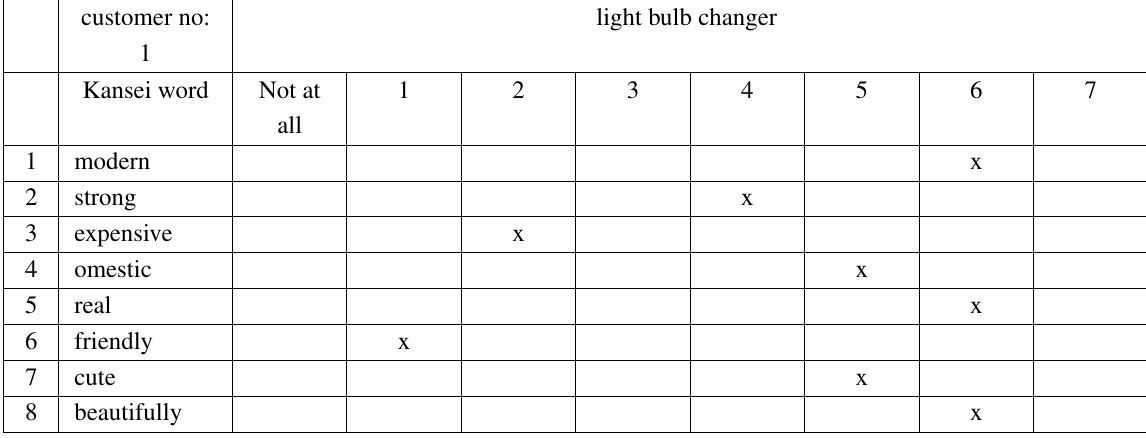
Table 2. An example of the response of participant